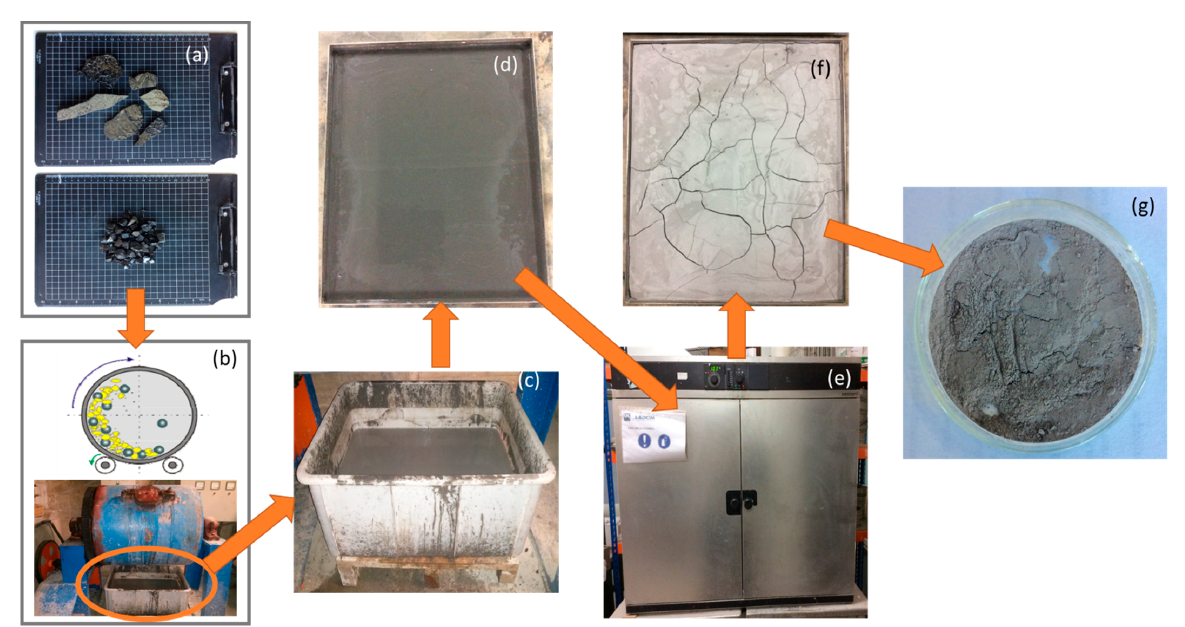
Figure 1. Cupola slag manufacture process.